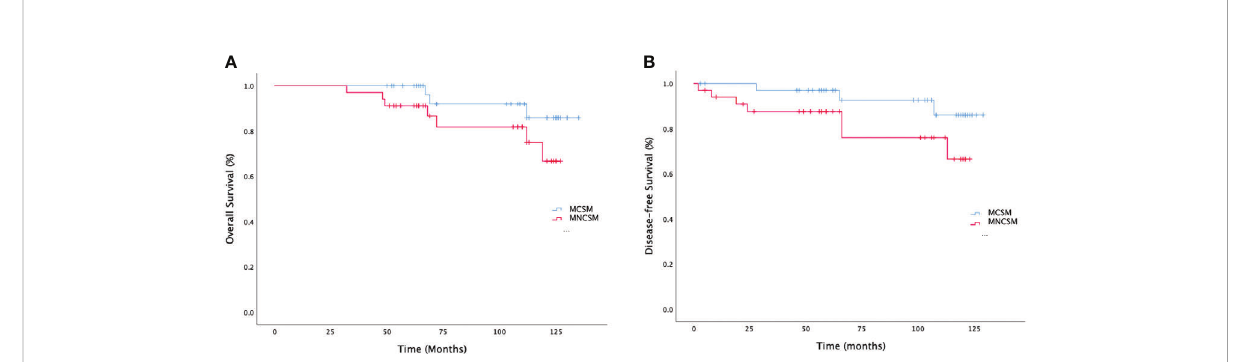
FIGURE 5 The survival analysis of modi fi ed shrinkage classi fi cation modes. (A) : The overall survival of MCSM and MNCSM among patients without pCR. (B) : The disease-free survival of MCSM and MNCSM among patients without